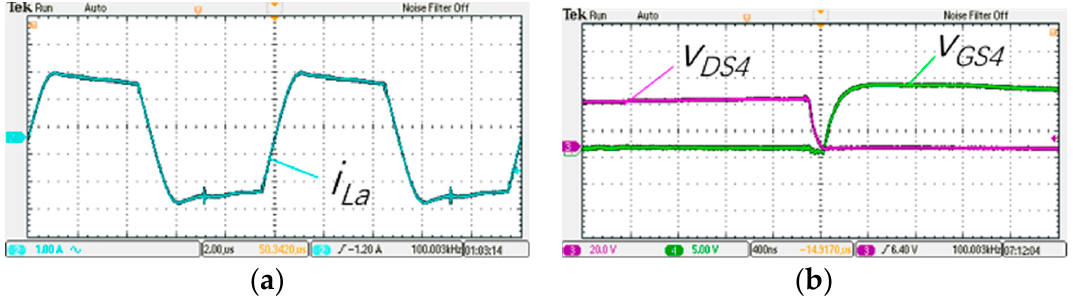
Figure 18. Injection current and lagging bridge arm waveform at 100 kHz. ( a ) Injection current; ( b ) Related waveform.